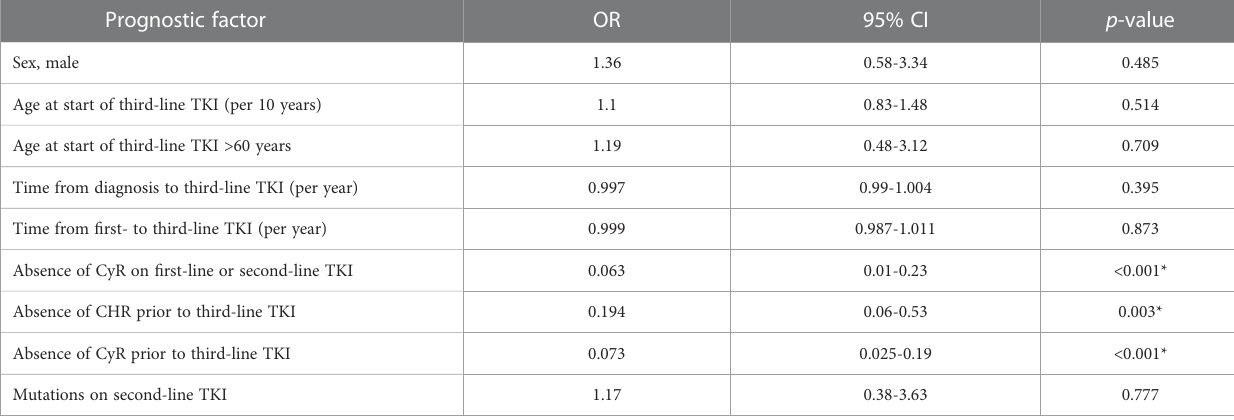
TABLE 3 Univariate regression analysis for the risk of not achieving a CCyR on third-line TKI therapy. Prognostic